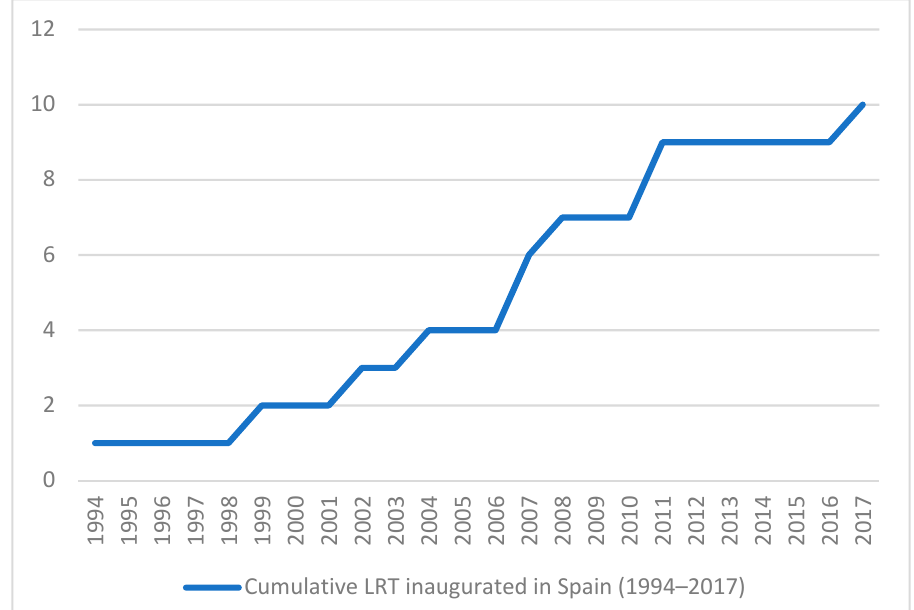
Figure 2. Cumulative LRT inaugurated in Spain (1994–2017).